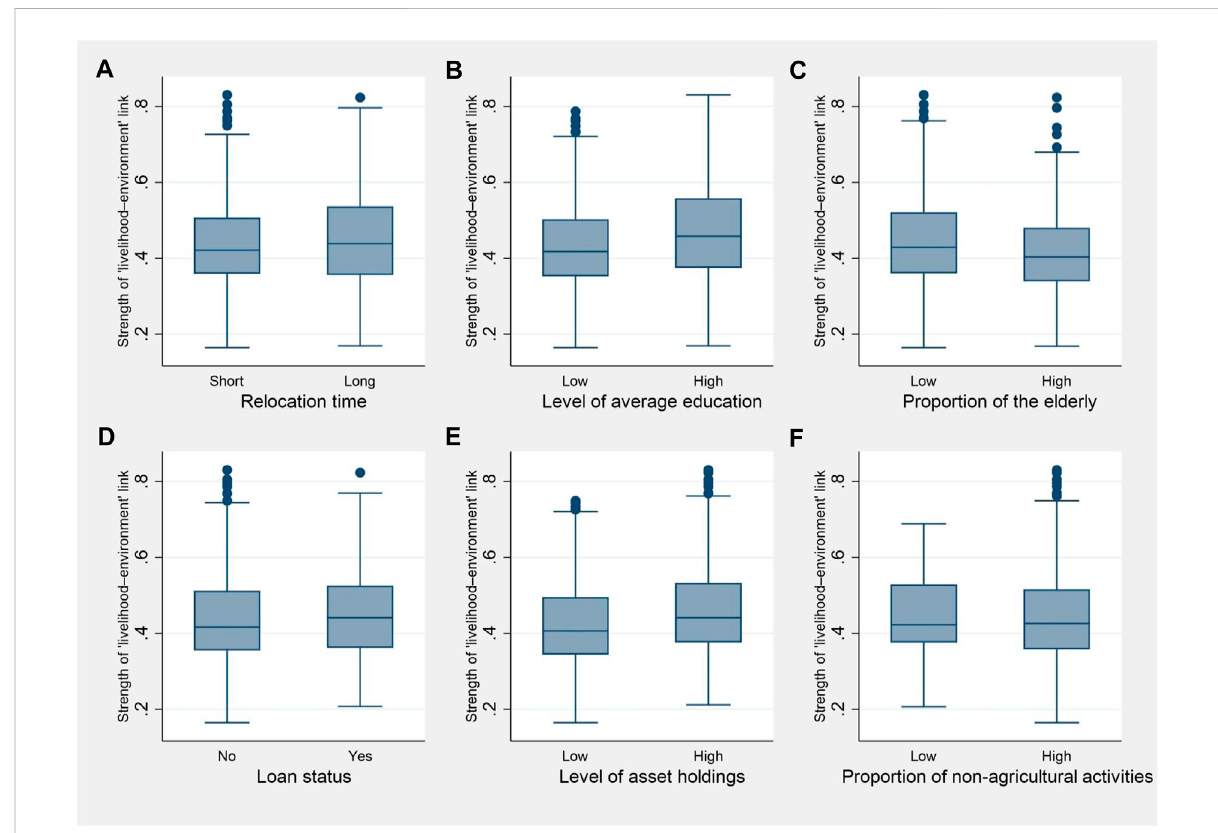
FIGURE 3 Distribution of “ livelihoods – environment ” links of different household groups (A) . Distribution of “ livelihoods-environment ” links of different relocation time; (B) . Distribution of “ livelihoods-environment ” links of different average education levels; (C) . Distribution of “ livelihoods- environment ” links of different elderly proportions; (D) . Distribution of “ livelihoods-environment ” links of different loan status; (E) . Distribution of “ livelihoods-environment ” links of different levels of asset holdings; (F) . Distribution of “ livelihoods-environment ” links of different proportions of non-agricultural activities. ① Groups of relocation time, average education, asset holdings and non-agriculture activities were divided by means, andthegroupsoftheelderlywasdividedby0.5proportion. ② Themeansofsubgroupsweresigni fi cantlydifferentat p < 0.05accordingtoabivariate correlation test.